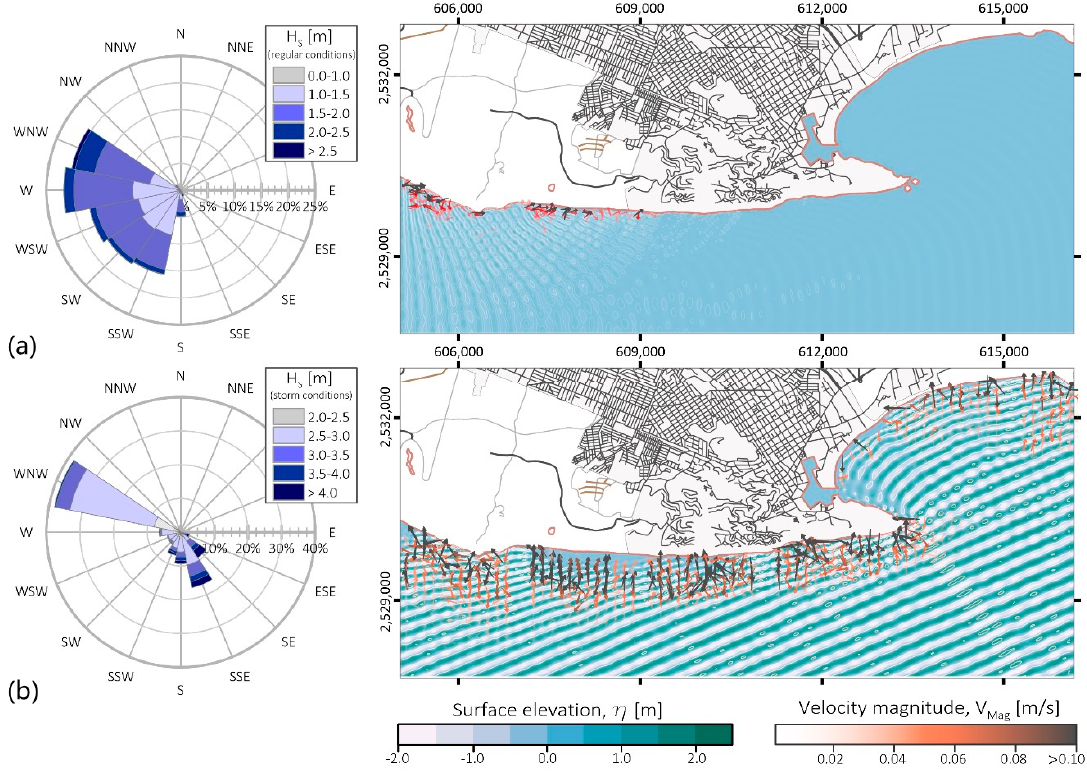
Figure 3. Wave rose diagrams for ( a ) normal wave conditions and ( b ) extreme wave conditions based on M41 numerical buoy dataset. Wave propagation and wave-induced coastal currents results from WAPO and COCO2 models, respectively, considering H S = 1.60 m, T P = 13.4 s, W–E wave propagation (regular conditions), and H S = 3.30 m, T P = 12.3 s, SSE–NNW wave propagation (extreme conditions).